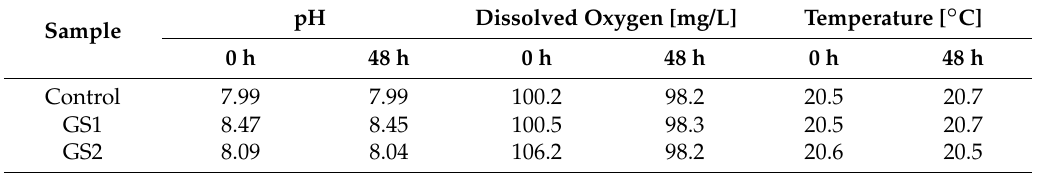
Table 6. Physico-chemical indicators of water leachates of slag over the acute toxicity test of Daphnia magna. Sample